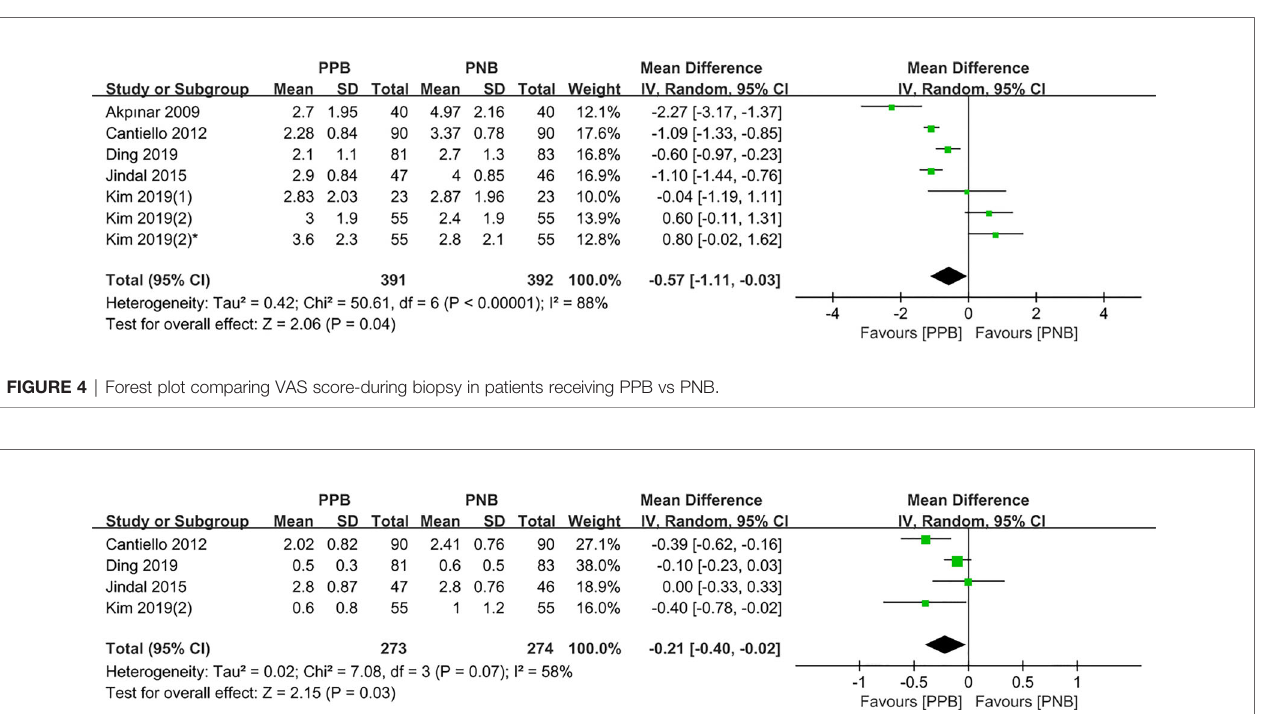
FIGURE 5 | Forest plot comparing VAS score-30 minute after biopsy in patients receiving PPB vs PNB.